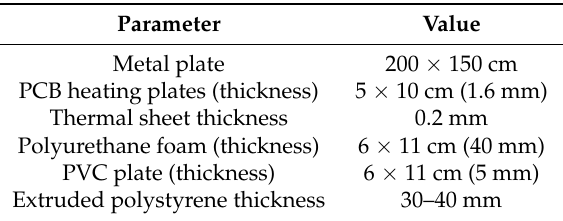
Table 1. Dimensions of the experimental